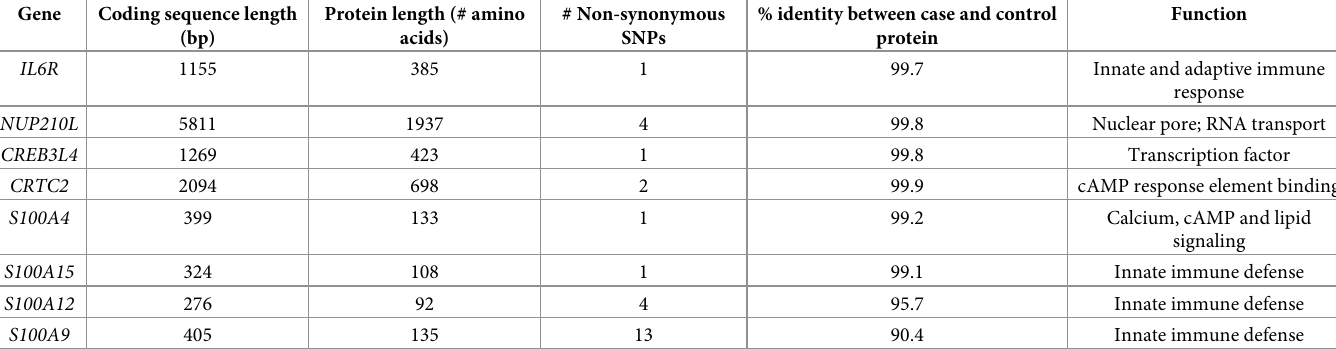
Table 1. Genes containing non-synonymous substitutions between case and control cats within the disease-associated locus. Coding sequence length